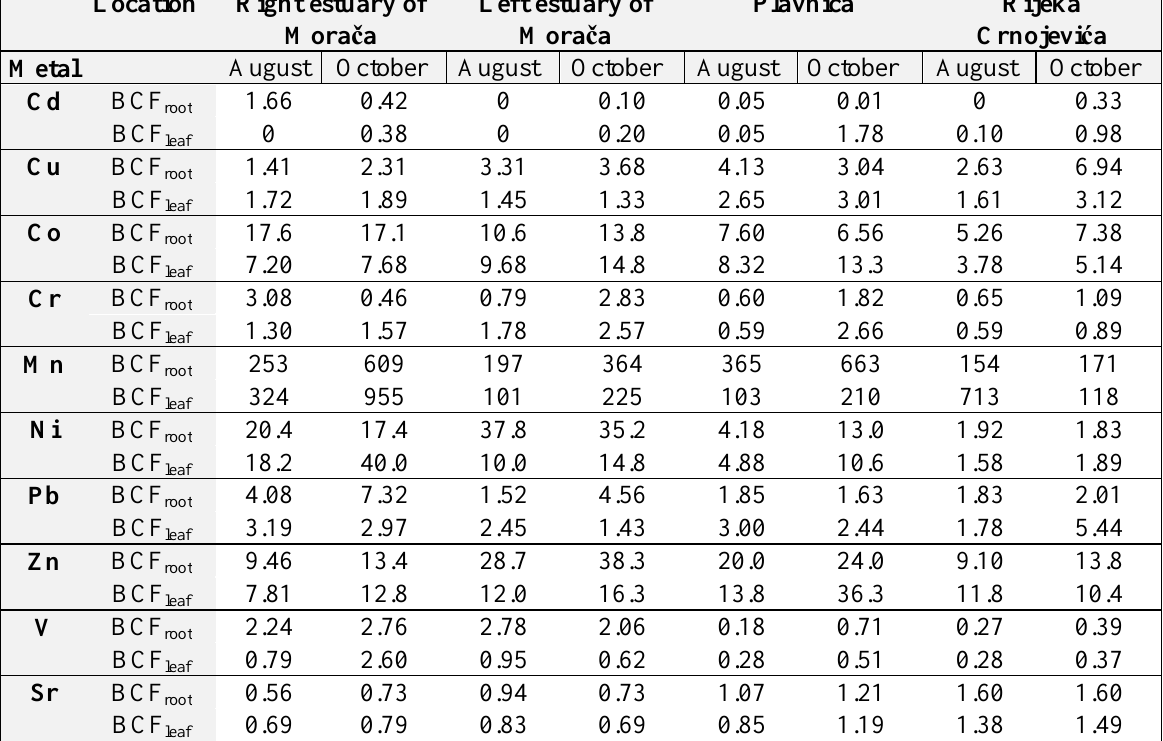
Table 3. - Temporal and spatial changes in the bioconcentration factor x 10 3 ) and the leaf (BCF for the root (BCF root/water